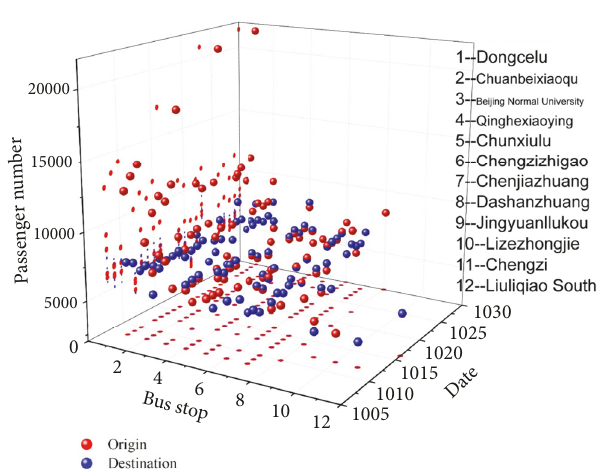
Figure 10: Five origin stops and five destination stops (X axis) with the largest passenger number with regular ODs (Z axis) for different date (Y axis).